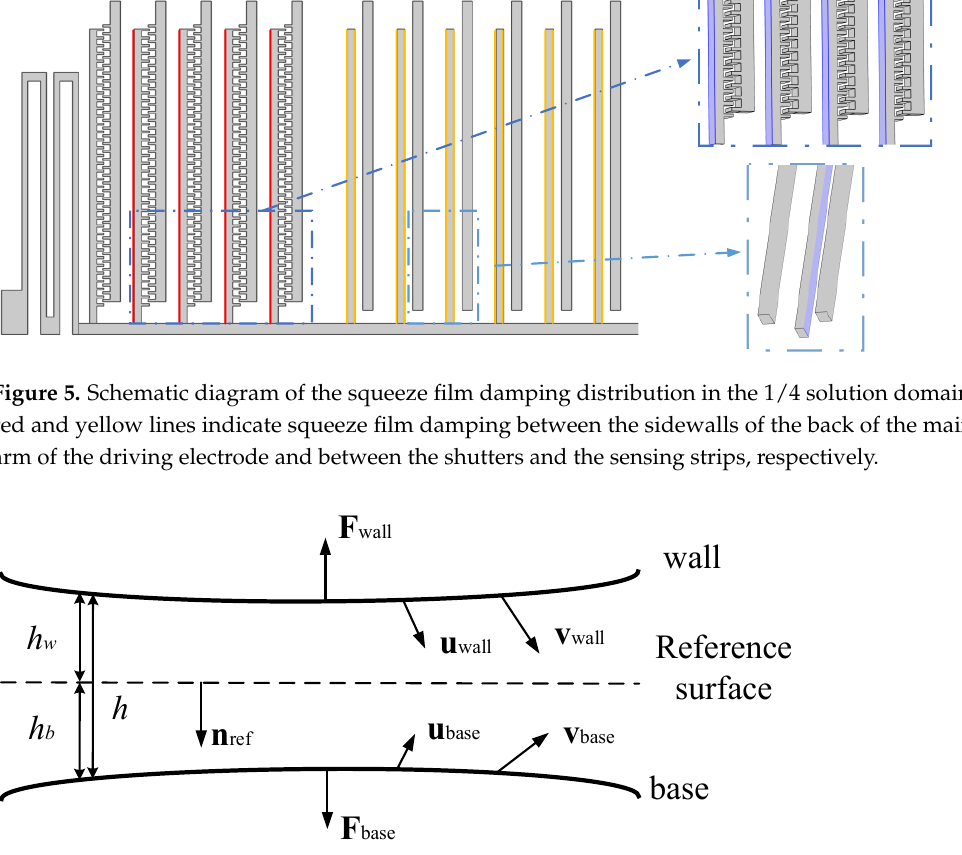
Figure 6. Schematic diagram of the thin film flow interface [29].